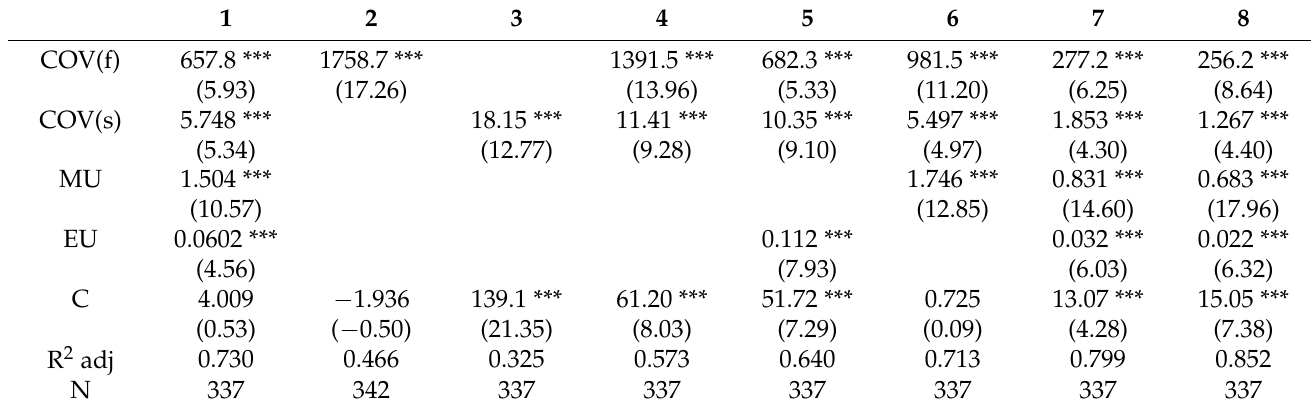
Table 8. COVID-19 death announcements and oil price volatility, world aggregated